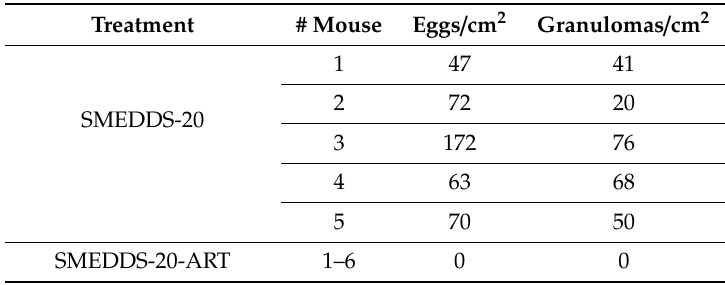
Table 3. The e ff ect of artemisone in micro-emulsion on schistosomal egg production and liver Table 3. The effect of artemisone in micro-emulsion on schistosomal egg production and liver granuloma granuloma load.